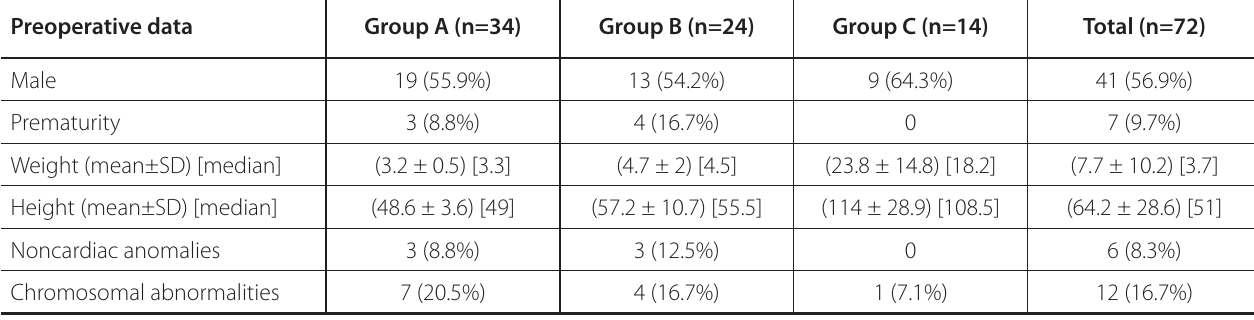
Table 1 . Preoperative data of patients who underwent surgical treatment for coarctation of the